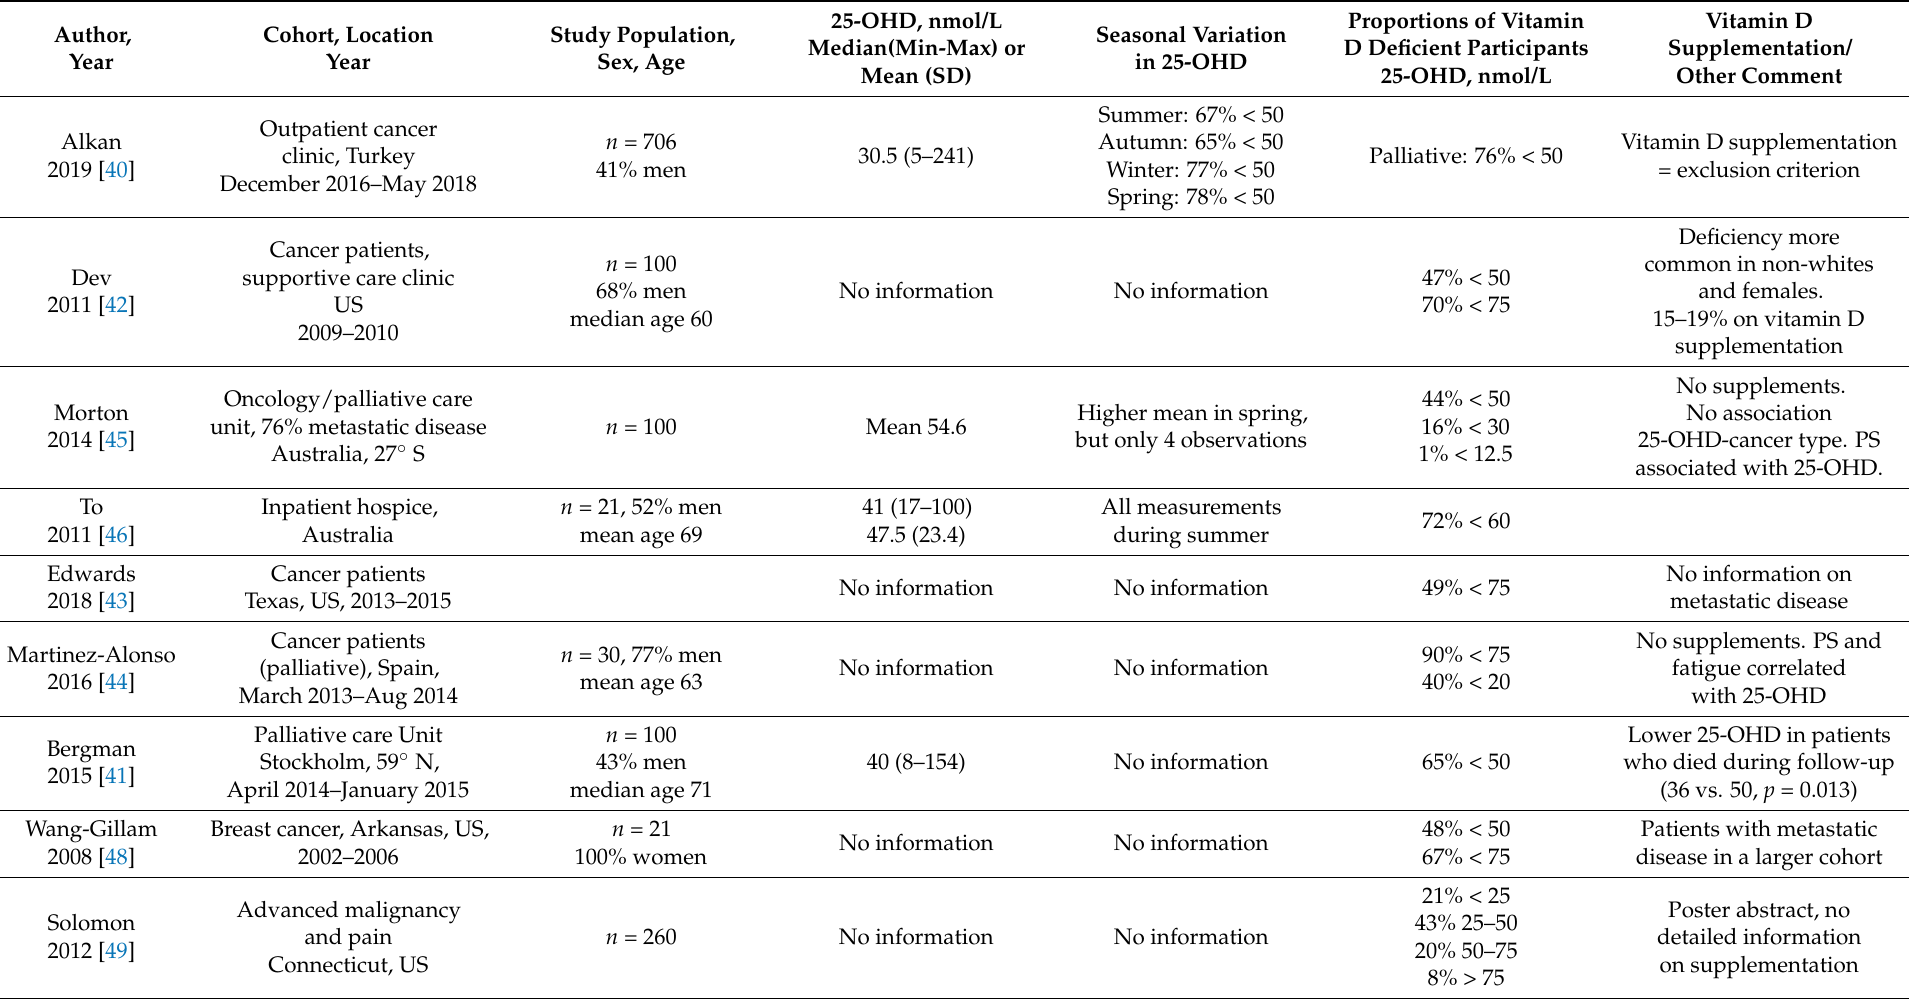
Table 1. Cross-sectional cohorts with measurements of 25-OHD in patients with mixed tumor types in a palliative